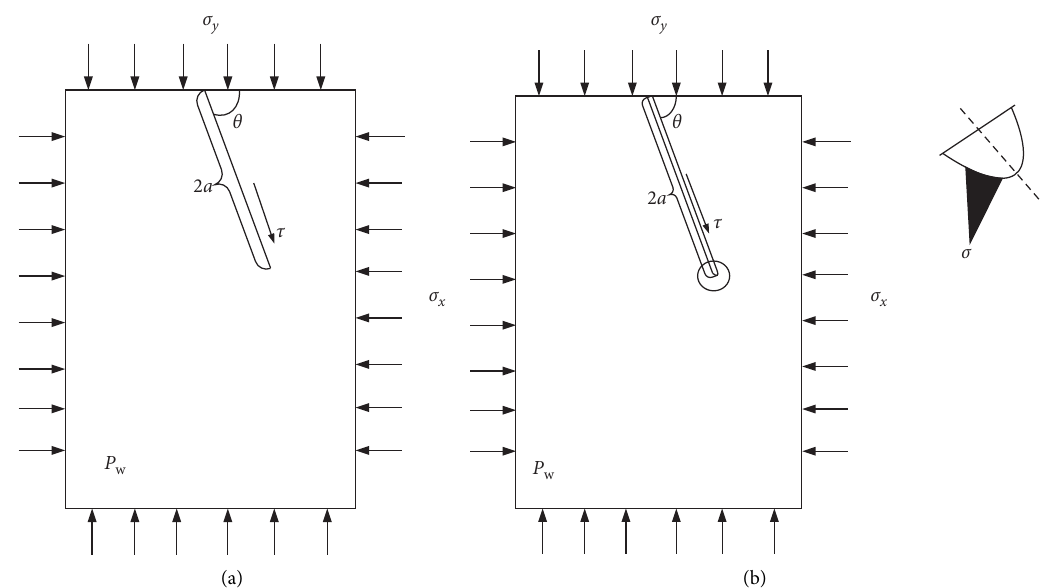
Figure 1: Schematic diagram of simplified mechanical model for boundary cracks in compression-shear state. (a) Closed crack. (b) Open